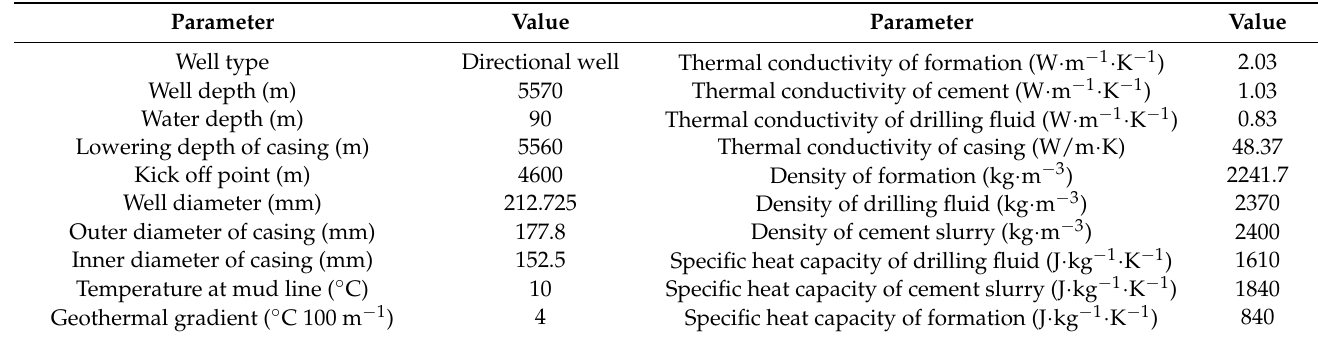
Table 2. Basic parameters of Well X2.